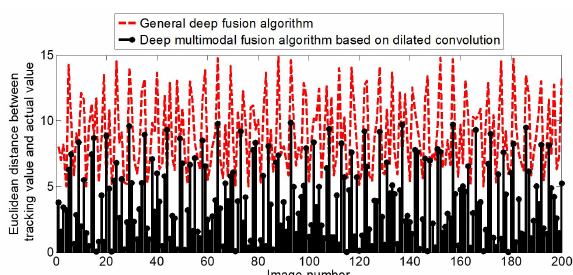
Fig. 10. Error analysis of the two tracking algorithms